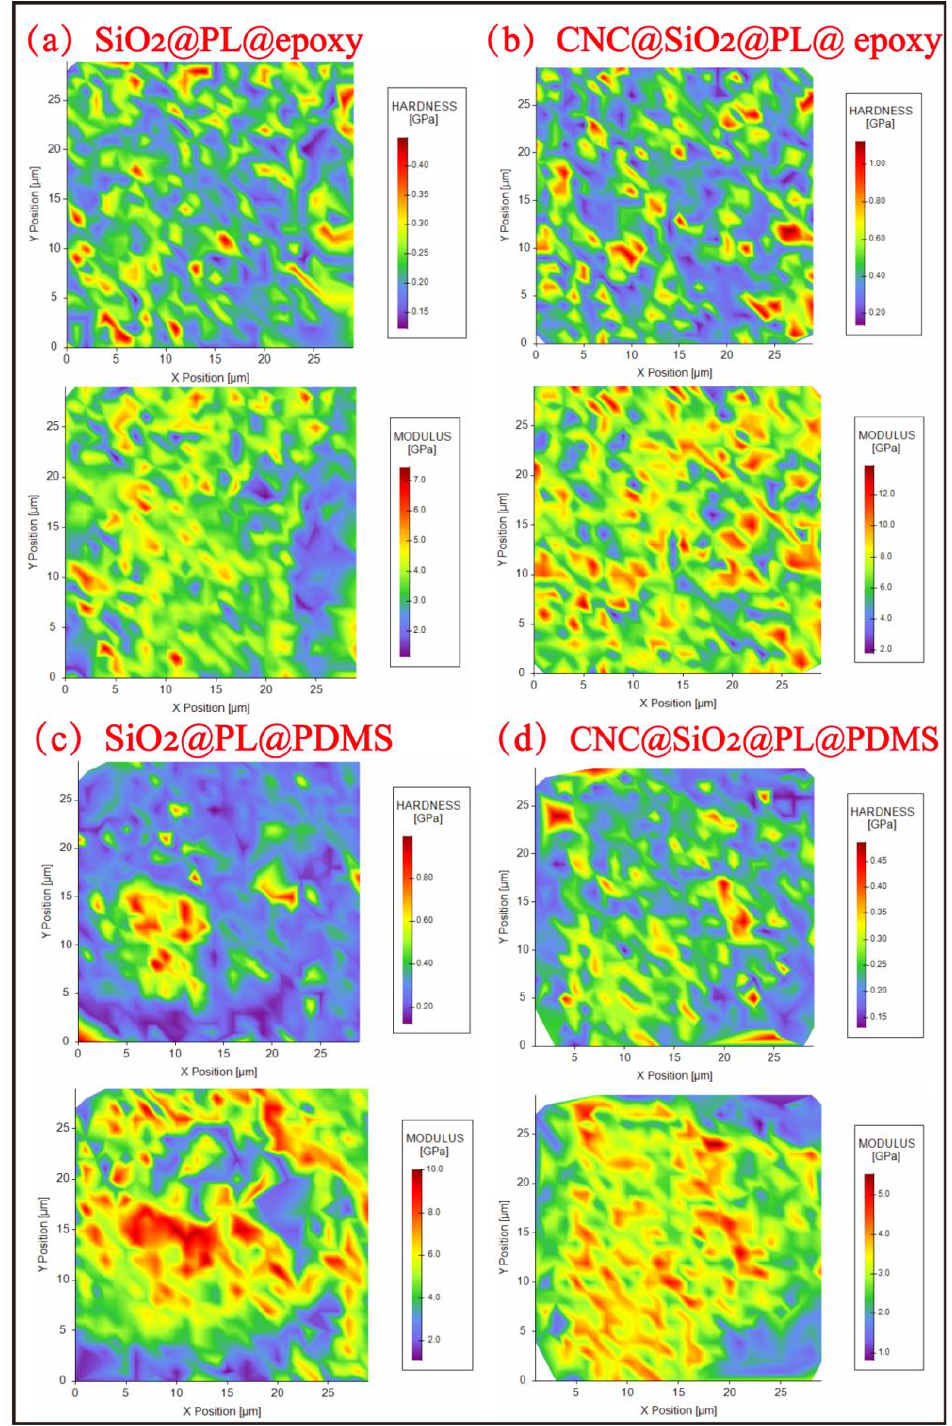
Figure 8. Nanoindentation analysis of different samples: ( a ) SiO 2 @PL@epoxy, ( b ) CNC@SiO 2 @PL epoxy, ( c ) SiO 2 @PL@PDMS and ( d ) CNC@SiO 2 @PL@PDMS coatings.